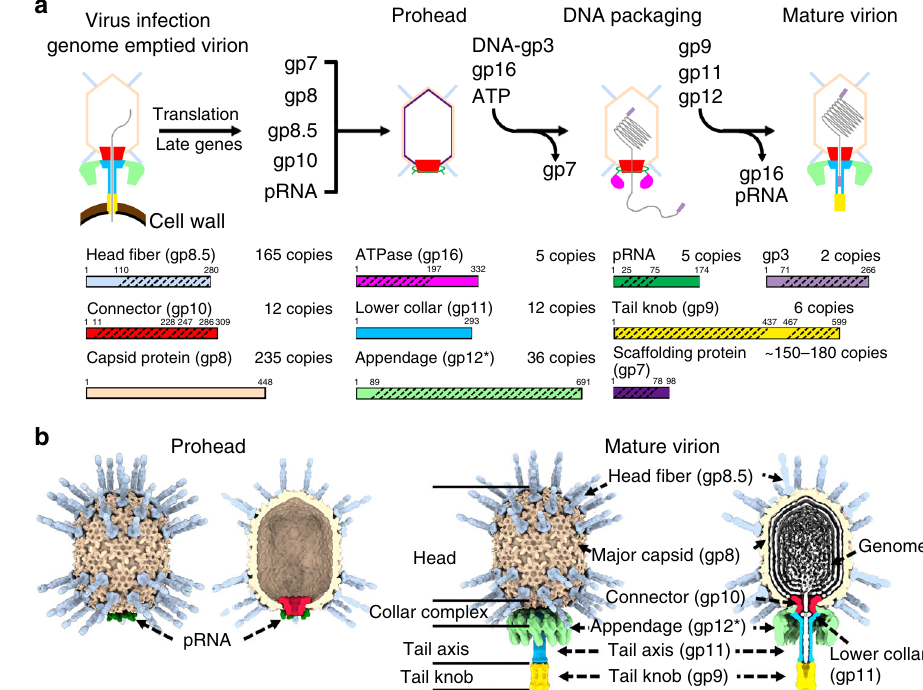
Fig. 1 Schematic diagrams showing the life cycle, key particles, and structural components of the bacteriophage ϕ 29. a Top: A schematic diagram showing the life cycle of ϕ 29; bottom: diagrams showing the polypeptide chains of the structure components. The oblique dashed lines indicate the portions for which the atomic structures are available. b Surface shadowed diagrams show key particles of ϕ 29. A cross-section is shown at the right side of each particle. The head fi bers are colored cyan. The major capsids are colored brown. The connectors are colored red. The low collars are colored light blue. The appendages (tail spikes) are colored green. The tail knobs are colored